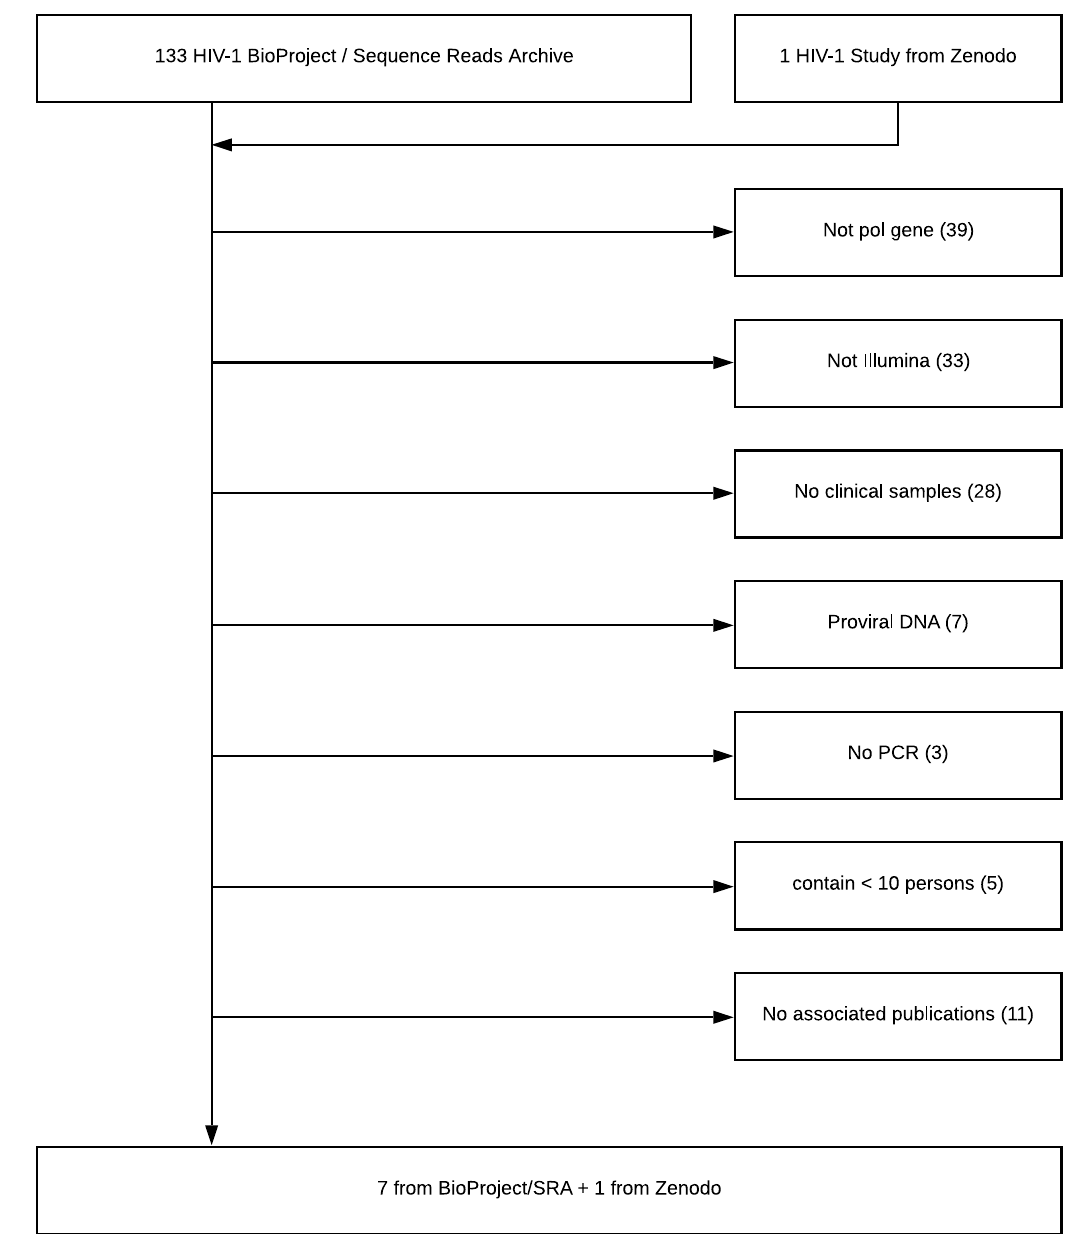
Fig 1. Flowchart of study selection process. Of 133 studies in the NCBI BioProject Sequence Read Archive as of August 1, 2019, seven met study selection criteria. One additional study was identified in the research upload site Zenodo (https://zenodo.org/).